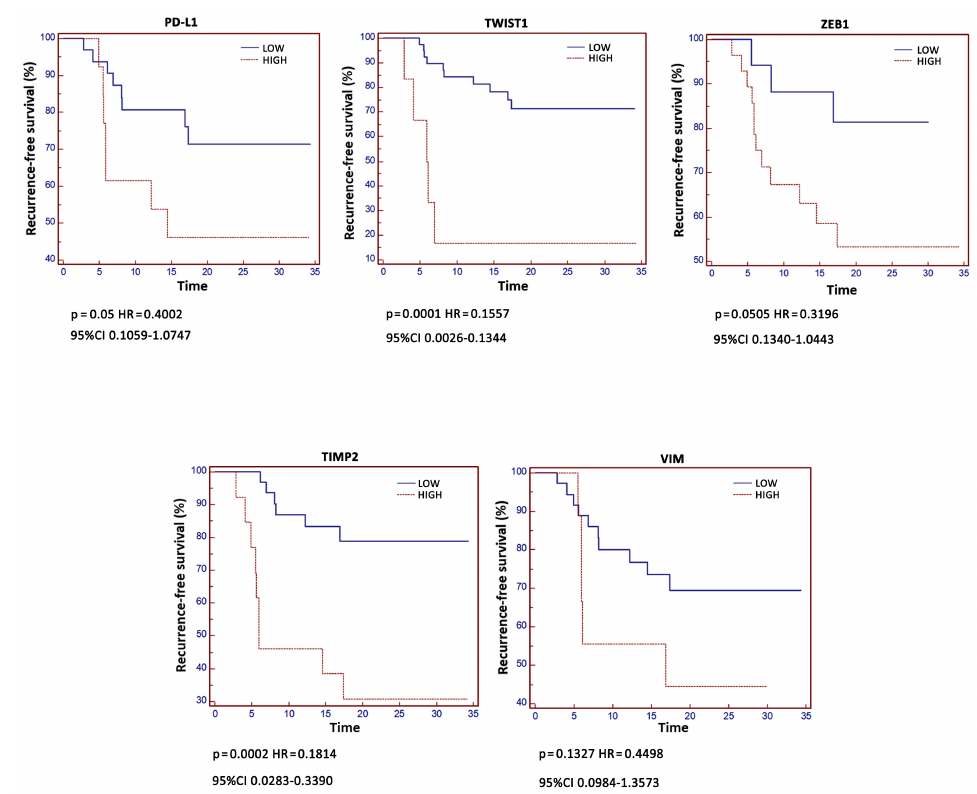
Figure 5. Kaplan–Meier analysis according to gene expression. Kaplan–Meier analysis was evaluated